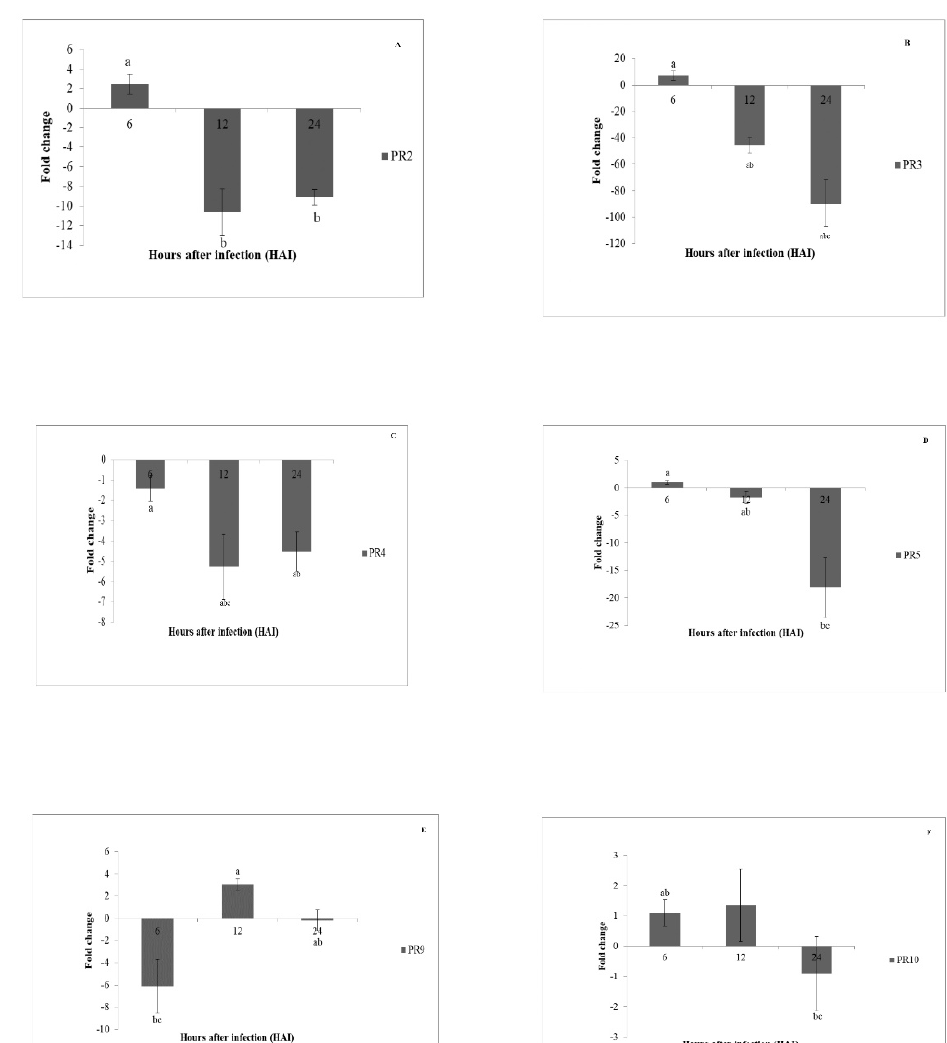
Figure 7. Temporal changes in PR gene ( A . PR2, B . PR3, C . PR4, D . PR5, E . PR9, F . PR10, G . PR12, H . PR16, I . PDI) expression of Triticum aestivum (var. GW322) on endophytic ( P. aeruginosa PM389) challenge from 0–24 HAI. Vertical bars represent standard deviation. The mean values were com- pared, using Duncan’s multiple range test (DMRT) at p < 0.05. Values that were significantly differ- ent from each other are headed by different letters in each bar of treatment. 3.9. Colonization Studies Based on level of the 16S rRNA gene transcript, no certain trend of colonization was observed. At 6 HAI, significant increase (n = 12, p < 0.05) of the 16S rRNAs of P. aeruginosa PM389 was observed (Figure 8). However, an approximately 6-fold decrease was ob- served in the level of bacterial transcript from plant samples collected at 12 HAI. Then, the level of bacterial transcript increased by 2.5-folds at 24 HAI.